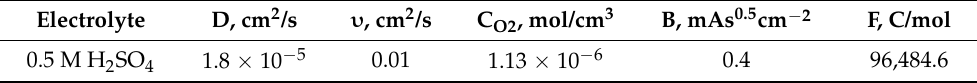
Table 4. Parameter values for the Koutecky–Levich equation.